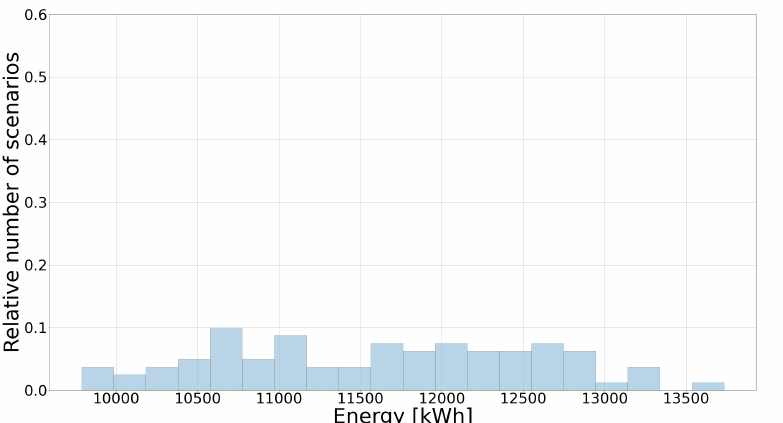
Figure 15. Histogram with PV time series magnitude increased by 20%.